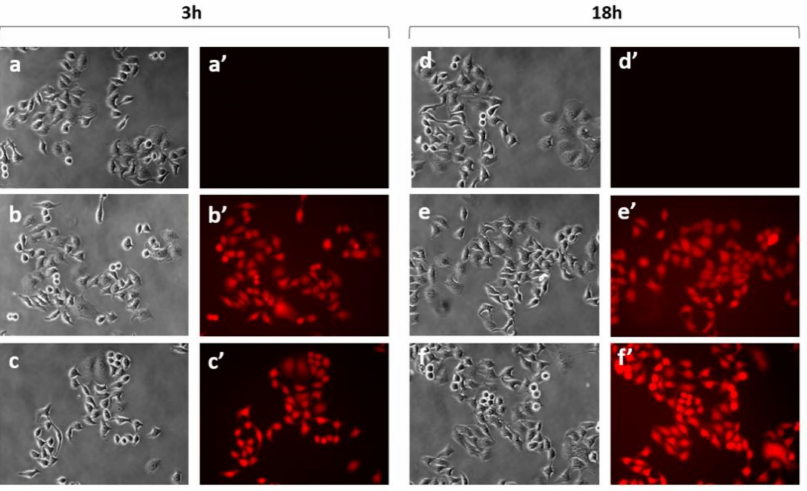
Figure 5. Representative phase contrast ( a – f ) and TRITC fluorescence ( a (cid:48) – f (cid:48) ) images measured on the control HeLa samples after 3 h ( a , a (cid:48) ) and 18 h ( d , d (cid:48) ); HeLa cells incubated with C 60 @HSA-TRITC after 3 h ( b , b (cid:48) ) and 18 h ( e , e (cid:48) ); C 60 @HSA-FA-TRITC after 3 h ( c , c (cid:48) ) and 18 h ( f , f (cid:48) ). The HeLa cells incubated with both C 60 @HSA-TRITC and C 60 @HSA-FA-TRITC showed cytoplasmatic red fluorescence after 3 h of incubation, demonstrating that the internaliza- tion of C 60 @HSA took place both in the presence and in the absence of folate derivatization. Control experiments performed on the HeLa cells, which were not incubated with any C 60 @HSA-TRITC derivatives, did not reveal any relevant fluorescence